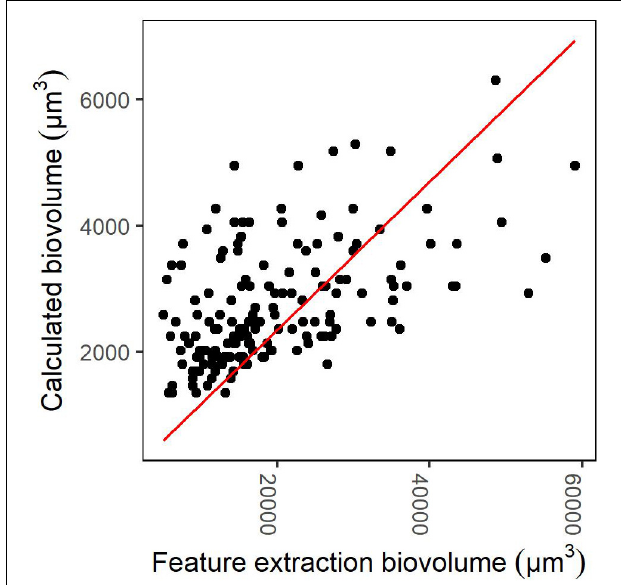
FIGURE 3 | Linear model for the conversion factor of the biovolumes of the category Dolichospermum “coiled” with regression line with intercept of zero. The calculated biovolume represents the biovolumes that were calculated for the images using the manual measurements and cell counts. The feature extraction biovolume means the corresponding biovolumes obtained by the feature extraction process.